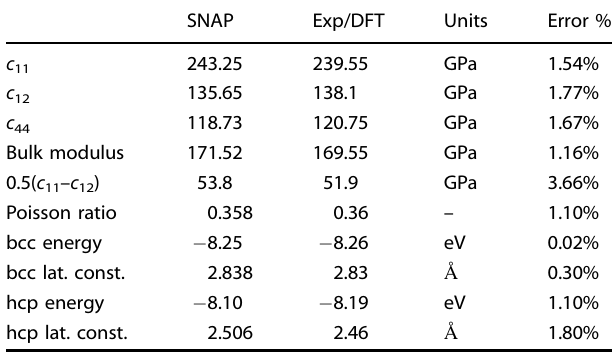
Table 2. Objective functions of the DAKOTA